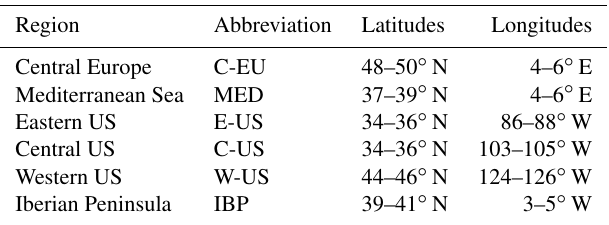
Table 1. Names, abbreviations and locations of the regions. Region Abbreviation Latitudes Longitudes Central Europe C-EU 48–50 ◦ N Mediterranean Sea MED 37–39 ◦ N 4–6 ◦ E Eastern US E-US 34–36 ◦ N 86–88 ◦ W Central US C-US 34–36 ◦ N 103–105 ◦ W Western US W-US 44–46 ◦ N 124–126 ◦ W Iberian Peninsula IBP 39–41 ◦ N 3–5 ◦